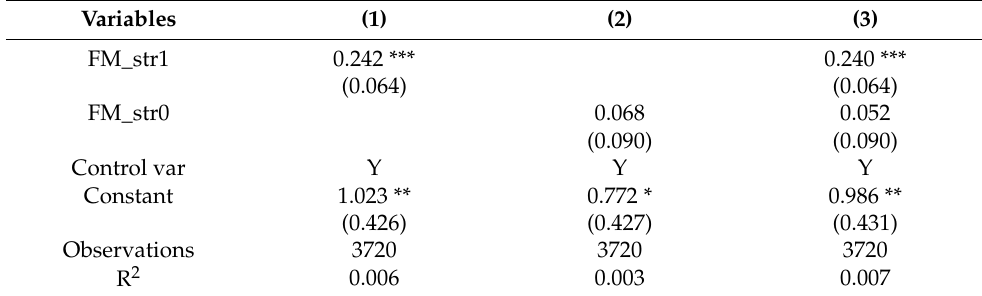
Table 5. Transform Estimation Method